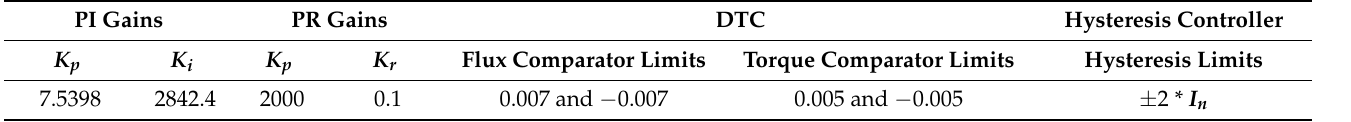
Table A2. Data of